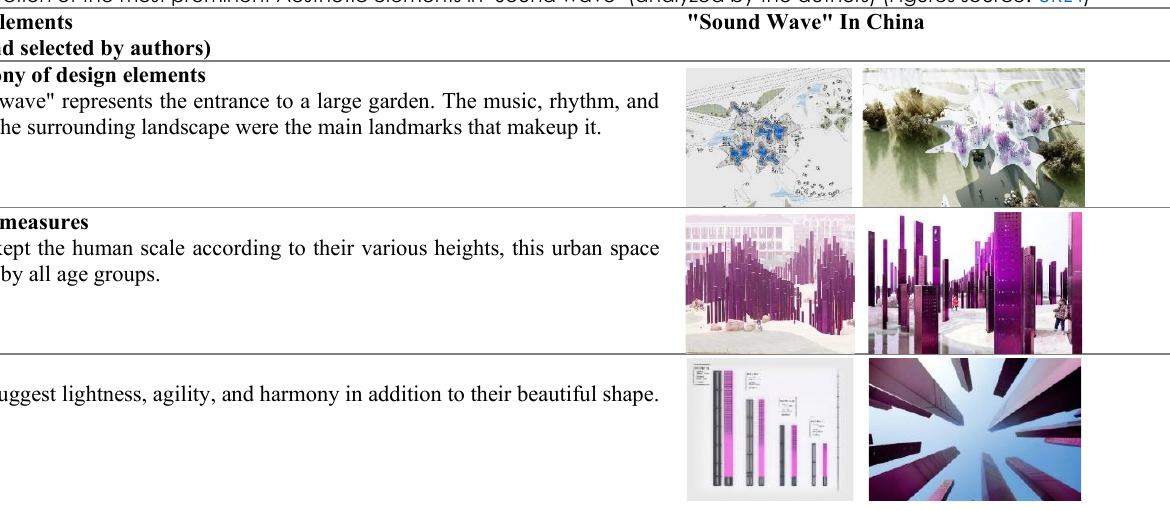
"Sound Wave" In China